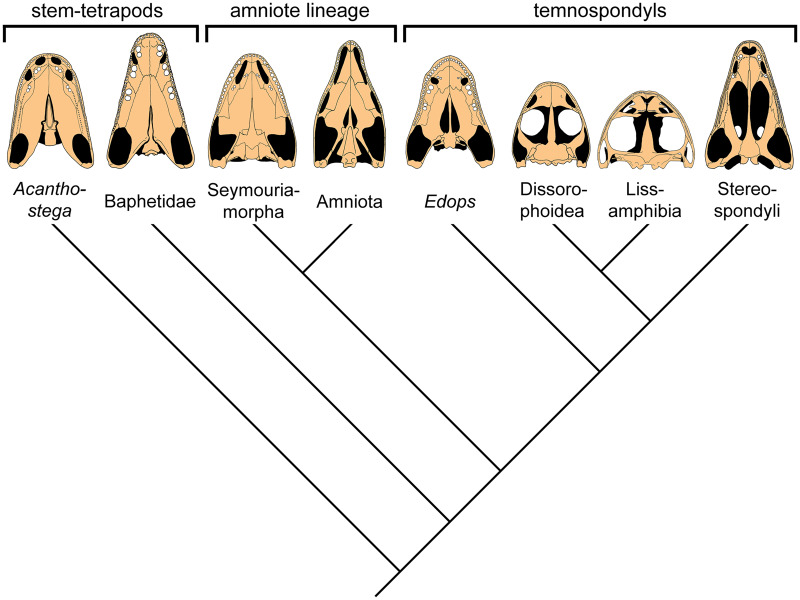
Simplified cladogram of early tetrapod relationships after Ruta and Coates (2007). Palates drawn after Romer and Witter (1942), Beaumont (1977), Reisz (1977), Duellman and Trueb (1994), Laurin (1996), Schoch and Milner (2000), Sigurdsen and Bolt (2010), and Clack (2012).